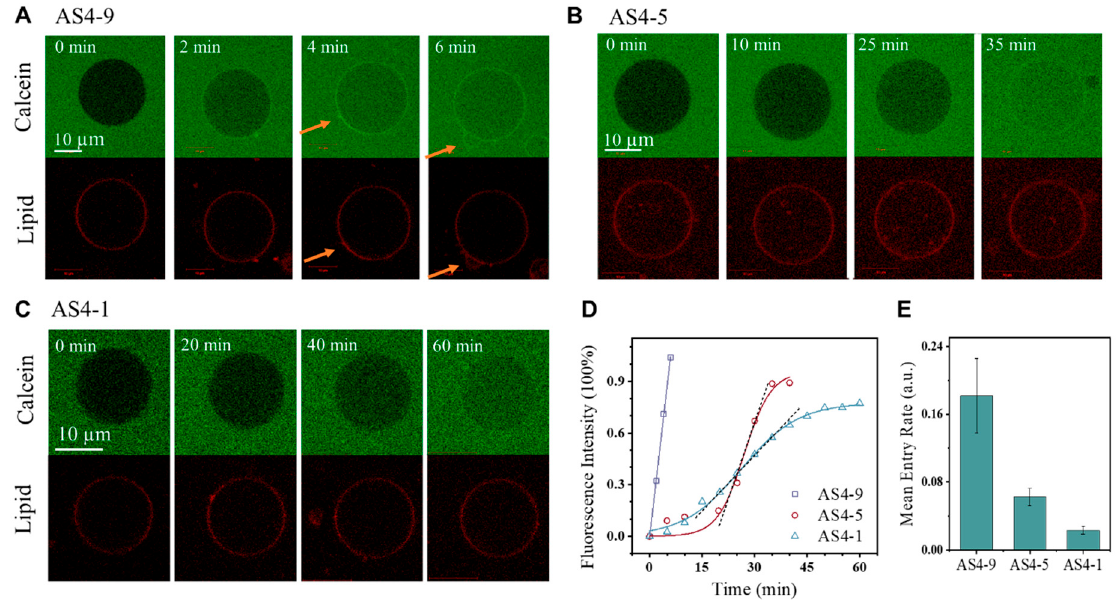
Figure 2. Peptide-induced membrane permeabilization. ( A – C ) Representative time series confocal images showing the transmembrane entry of calcein into a GUV due to peptide exposure. Images were taken in the green (calcein) and red (lipid) channels. ( D ) Corresponding scatter diagram showing the time-dependent increase in fluorescence intensity in the interior of the GUV due to drug-induced calcein entry. Fitting curves are shown with solid lines, following a linear equation of y = a + bx or a sigmoidal equation of y = a . The linear stage of each profile (marked with dotted line) 1 + exp ( − k × ( x − x c )) was used to calculate the mean entry rate of calcein ( E ). The membrane was composed of PC:PG = 7:3 by mol. The peptide concentration was 2.0 µ g mL − 1 . Orange arrows in ( A ) refer to the deformed membrane. The data in ( E ) are based on at least three repeated